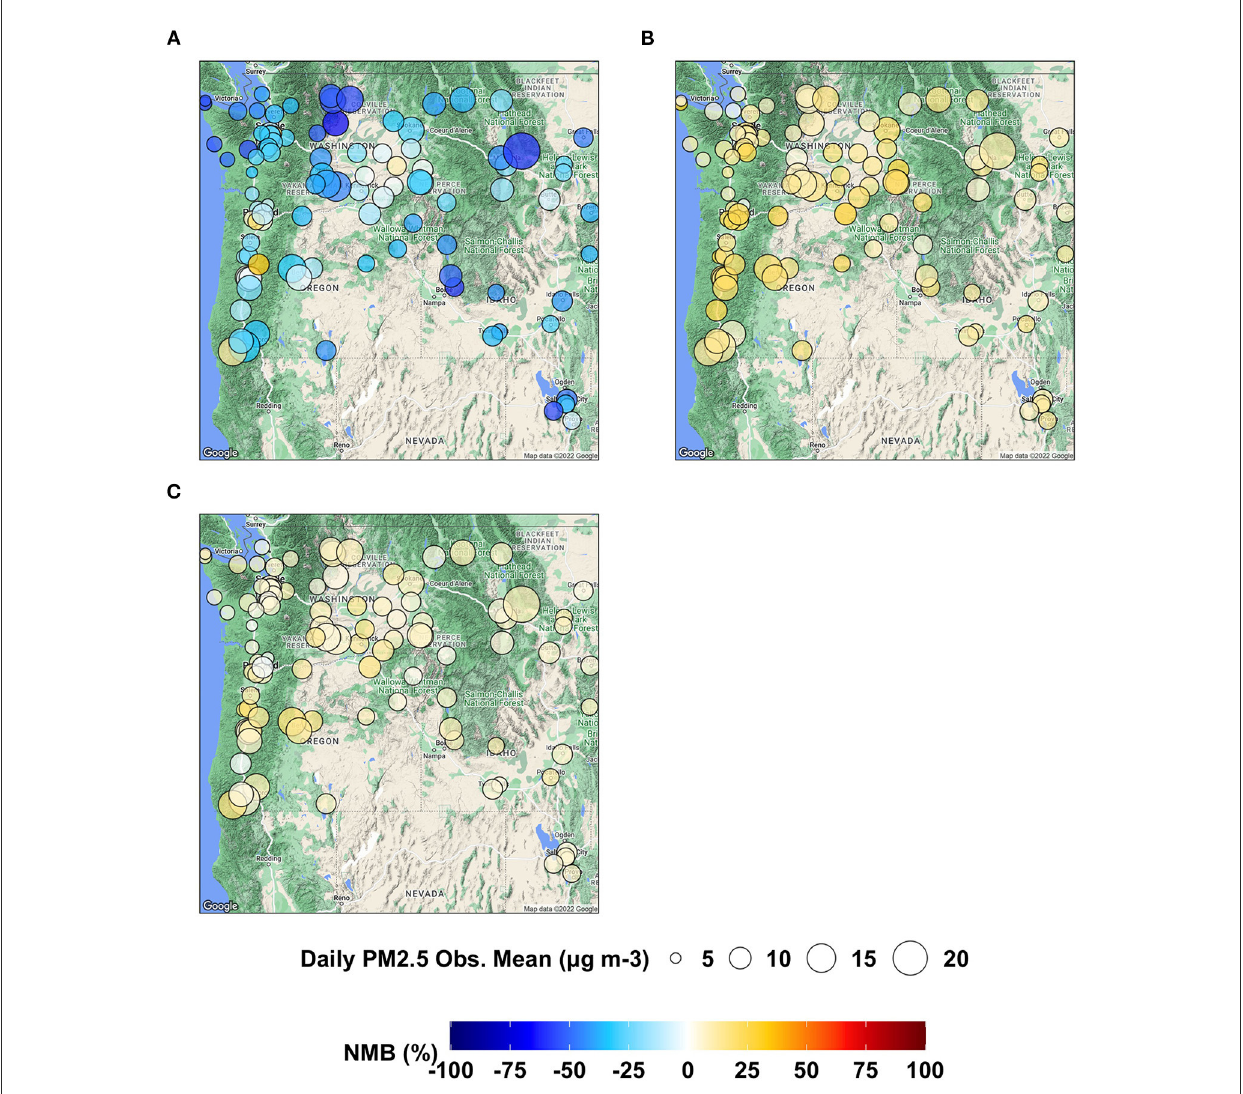
FIGURE7 Maps showing NMB of daily PM2.5 predictions from (A) AIRPACT, (B) ML1, and (C) ML2 at the AQS sites throughout the PNW in the wildfire season of 2017 to 2020.